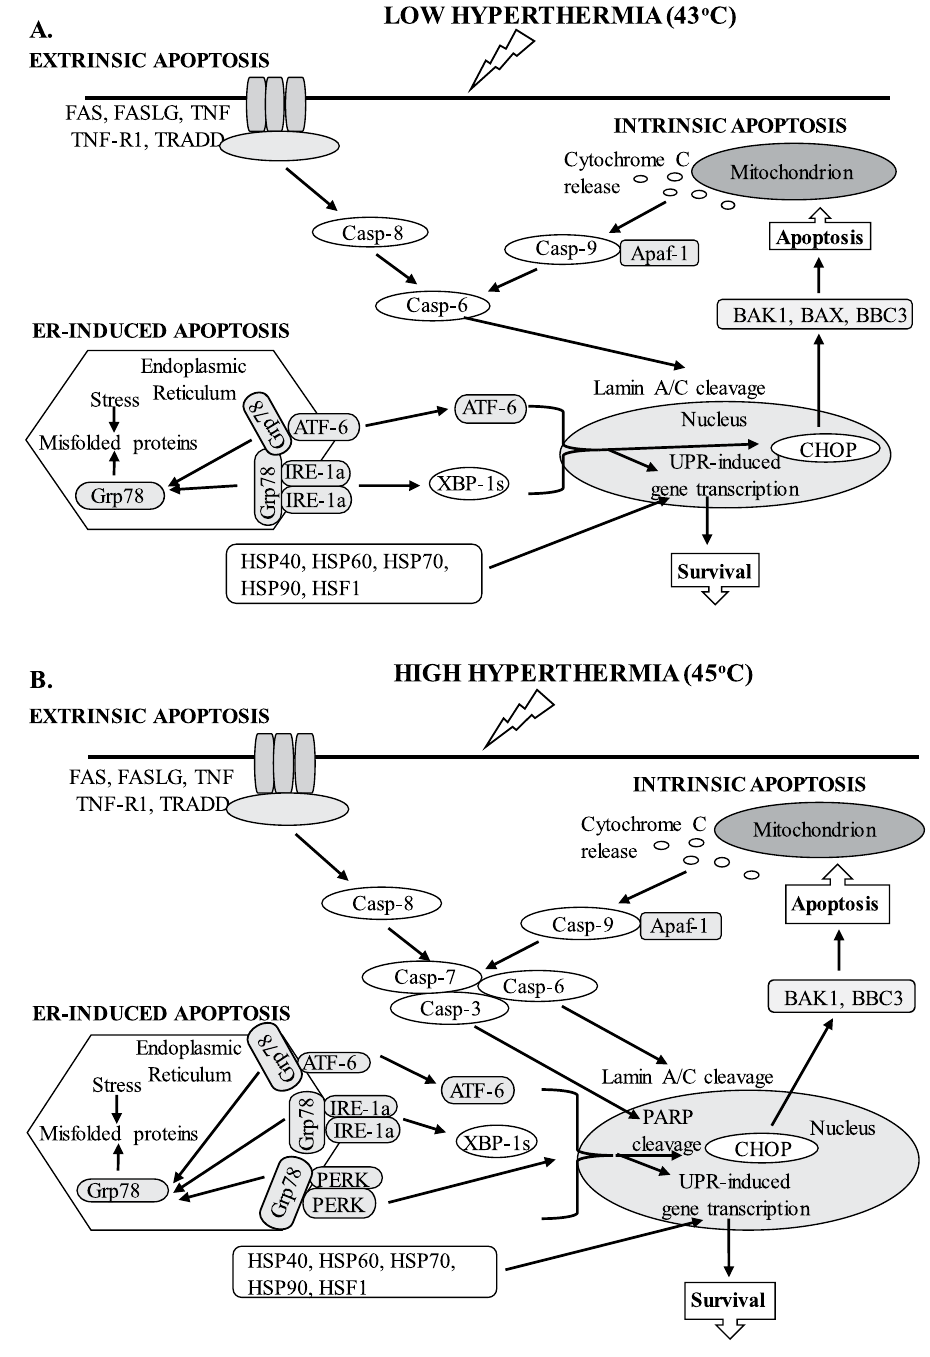
Figure 8. Schematic representation of proposed apoptotic induction in response to 43 °C ( A ) and 45 °C ( B ) hyperthermic exposures in human malignant melanoma (A375)